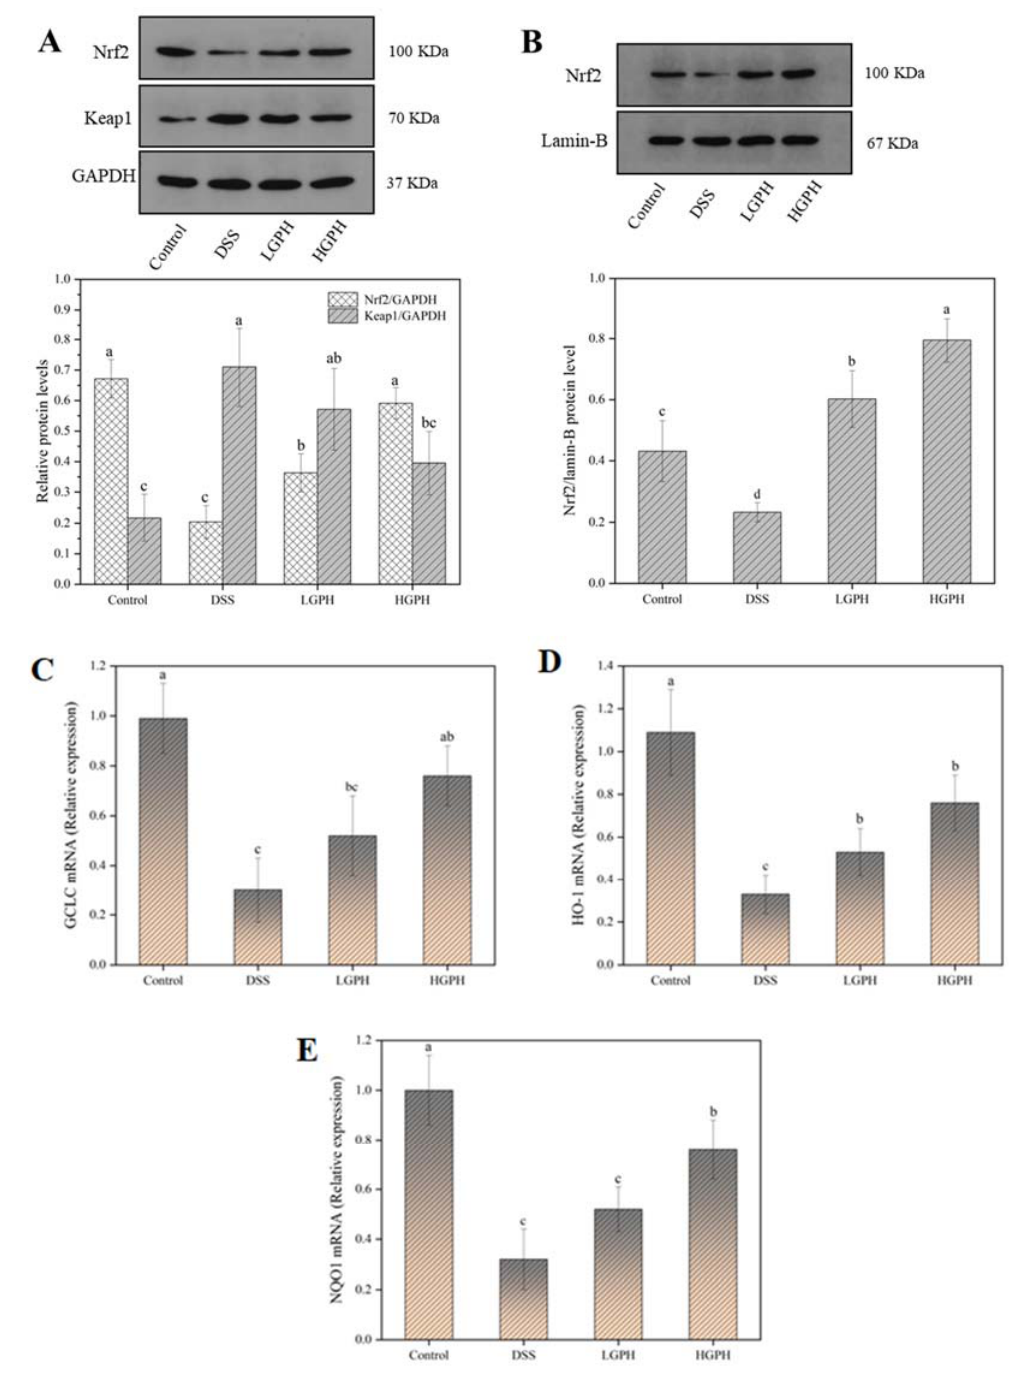
Figure 4. GPH extracts activated the Keap1/Nrf2 signaling pathway and promoted the mRNA expression of Nrf2 downstream genes. Relative protein expression levels of ( A ) Keap1 and cytosolic Nrf2; ( B ) Nuclear Nrf2. Relative mRNA expression levels of ( C ) GCLC; ( D ) HO-1; ( E ) NQO1. Values not sharing a common superscript letter denote significant difference ( p < 0.05).